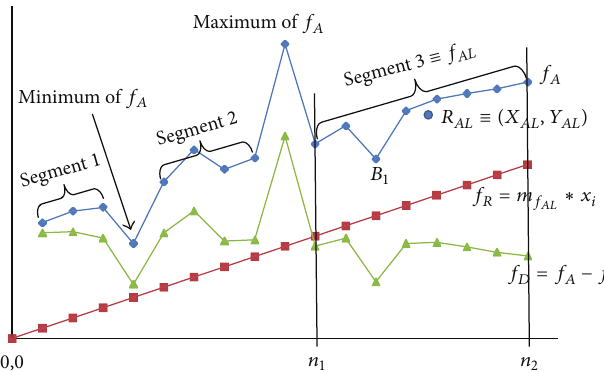
Figure 4: Transformation technique: if it is possible to find 𝑓 𝑅 which has the form of 𝑦 = 𝑚𝑥 in relation to 𝑓 𝐴 , then it is possible to find 𝑓 𝐷 as 𝑓 𝐴 − 𝑓 𝑅